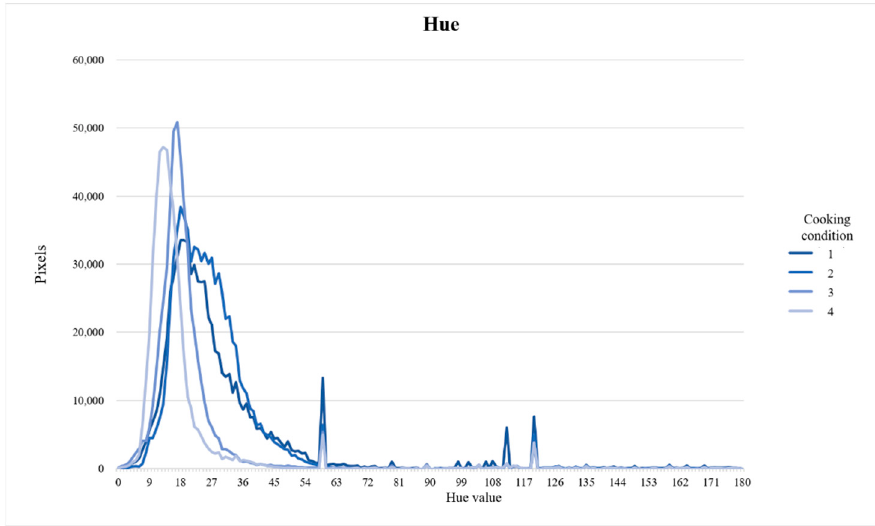
Figure 13. Hue comparison during cooking.